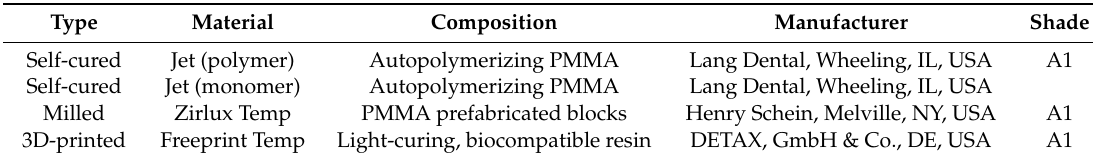
Table 1. Provisional resin materials and manufacturer information.